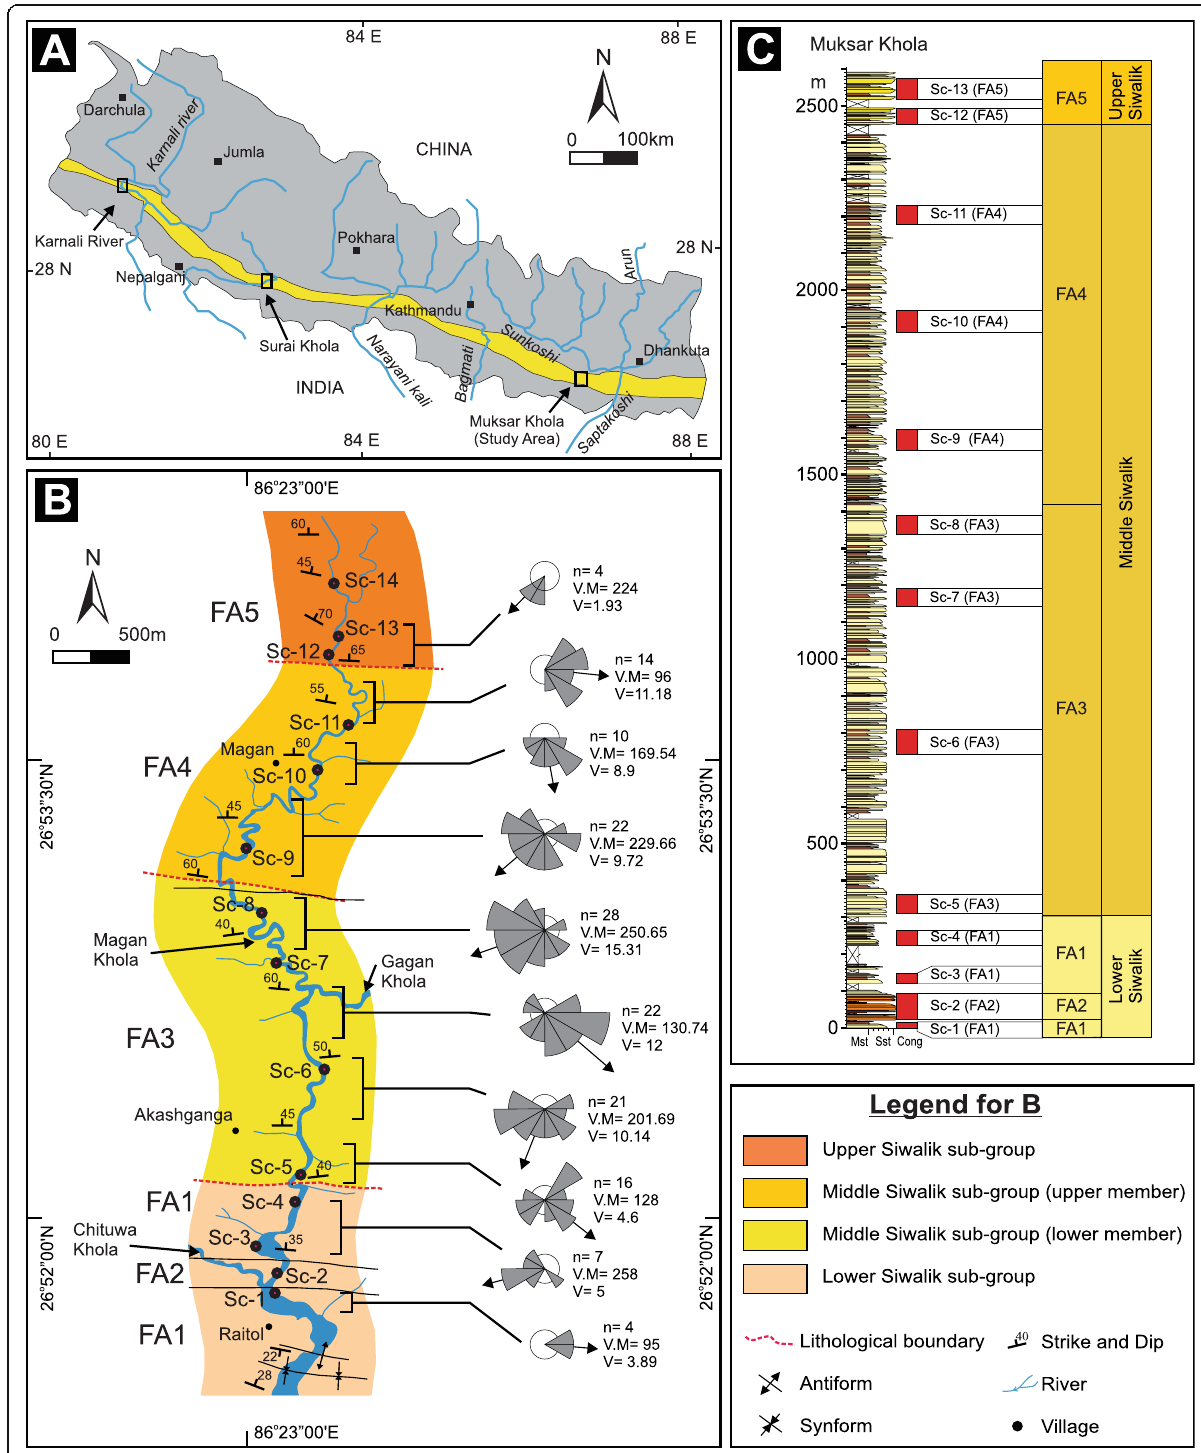
Fig. 1 A Map of Nepal (in grey) showing the Siwaliks range (in yellow) and the location of the present study area along with the Surai Khola section studied by Nakayama and Ulak (1999) and Karnali River section studied by Huyghe et al. (2005) and Sigdel and Sakai (2016); B geological map of the Siwaliks along the Muksar Khola section (modified after Rai and Yoshida 2020) showing the location of representative sedimentological log of the facies association and paleocurrent analysis; C sedimentological log of the Muksar Khola section (modified after Rai and Yoshida 2020) showing the location of sedimentological log of representative facies association (Sc-14 of FA5 lies beyond the sedimentological